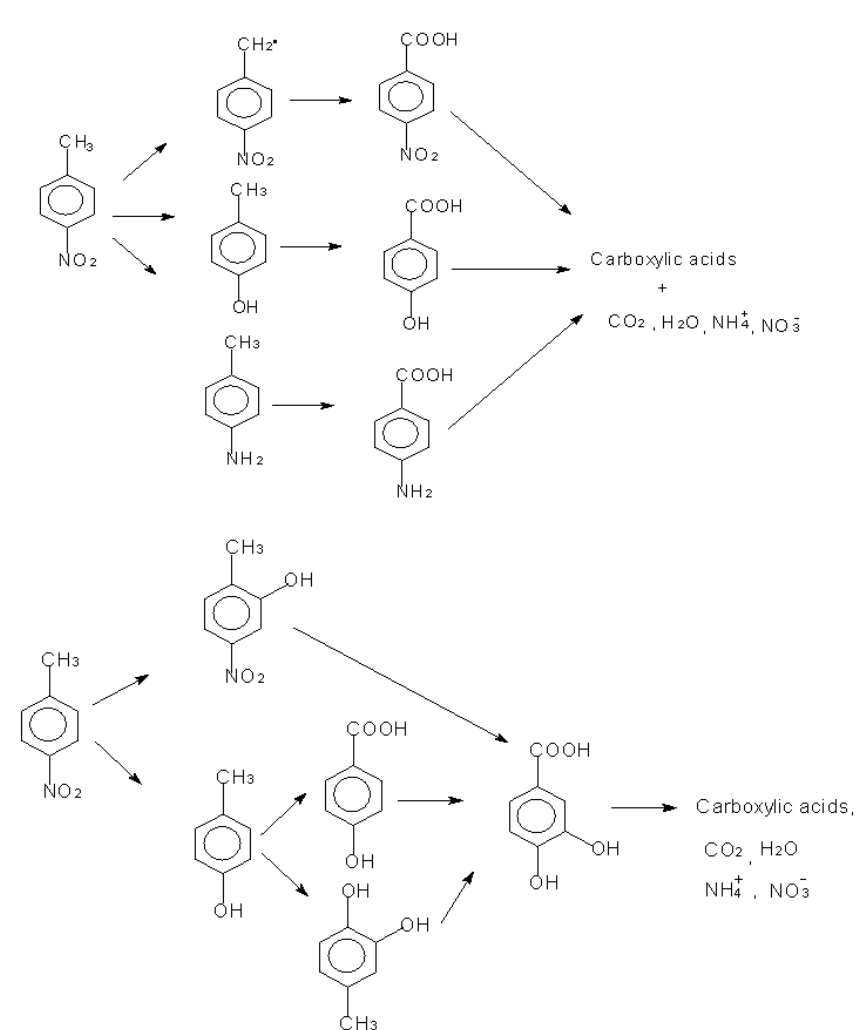
Scheme 1 The degradation pathways of